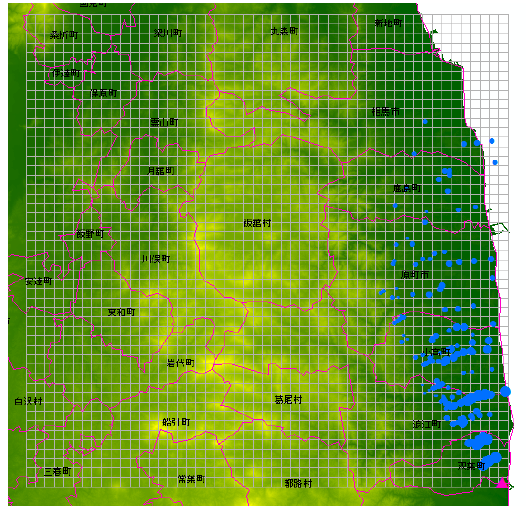
Figure 4. Particle trajectory estimated from wind directions and velocities on March